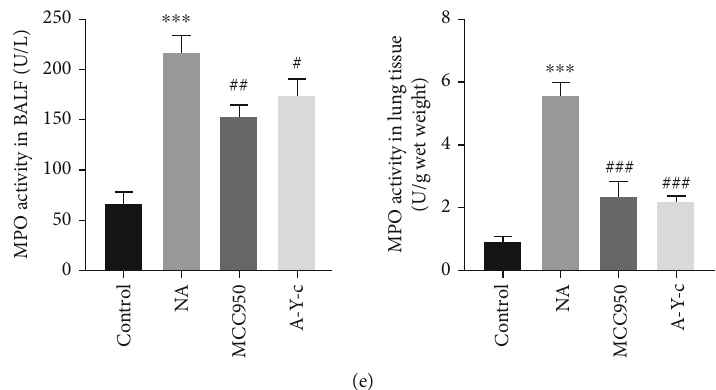
Figure 2: Blockade of the NLRP3/caspase-1/IL-1 β pathway ameliorated airway hyperresponsiveness, airway in fl ammation induced by ovalbumin. (a) Representative H&E-stained and PAS-stained lung sections of di ff erent groups. Original magni fi cation was 200x. (b) Semiquanti fi cation of airway in fl ammation and PAS staining was performed. (c) Resistance index (RI) to double multiplication concentration of methacholine (3.125, 6.25, 12.5, 25, and 50 mg/ml) was measured. (d) Number of total in fl ammatory cells, neutrophils, macrophages, lymphocytes, and eosinophils in BALF. (e) MPO activity in BALF and lung tissue. There were six mice in each group. Data are expressed as mean ± SEM . Compared to the control group, ∗ p < 0 : 05 , ∗∗ p < 0 : 01 , and ∗∗∗ p < 0 : 001 ; compared to the neutrophilic asthma group, # p < 0 : 05 , ## p < 0 : 01 , and ### p < 0 : 001 . NLRP3: nucleotide-binding oligomerization domain-like receptor family pyrin domain containing 3; MPO: myeloperoxidase; BALF: bronchoalveolar lavage fl